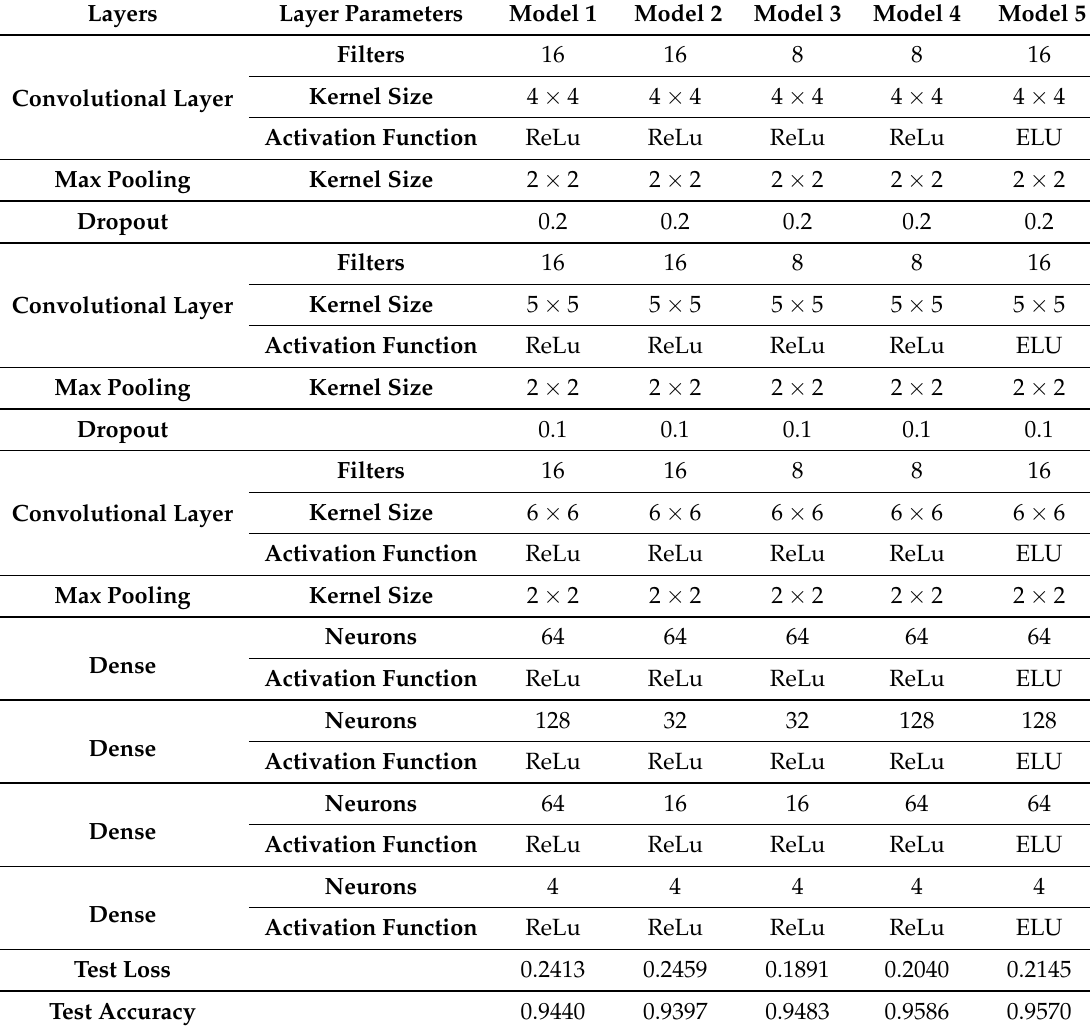
Table 1. Convolutional neural network (CNN) architecture variations for tested